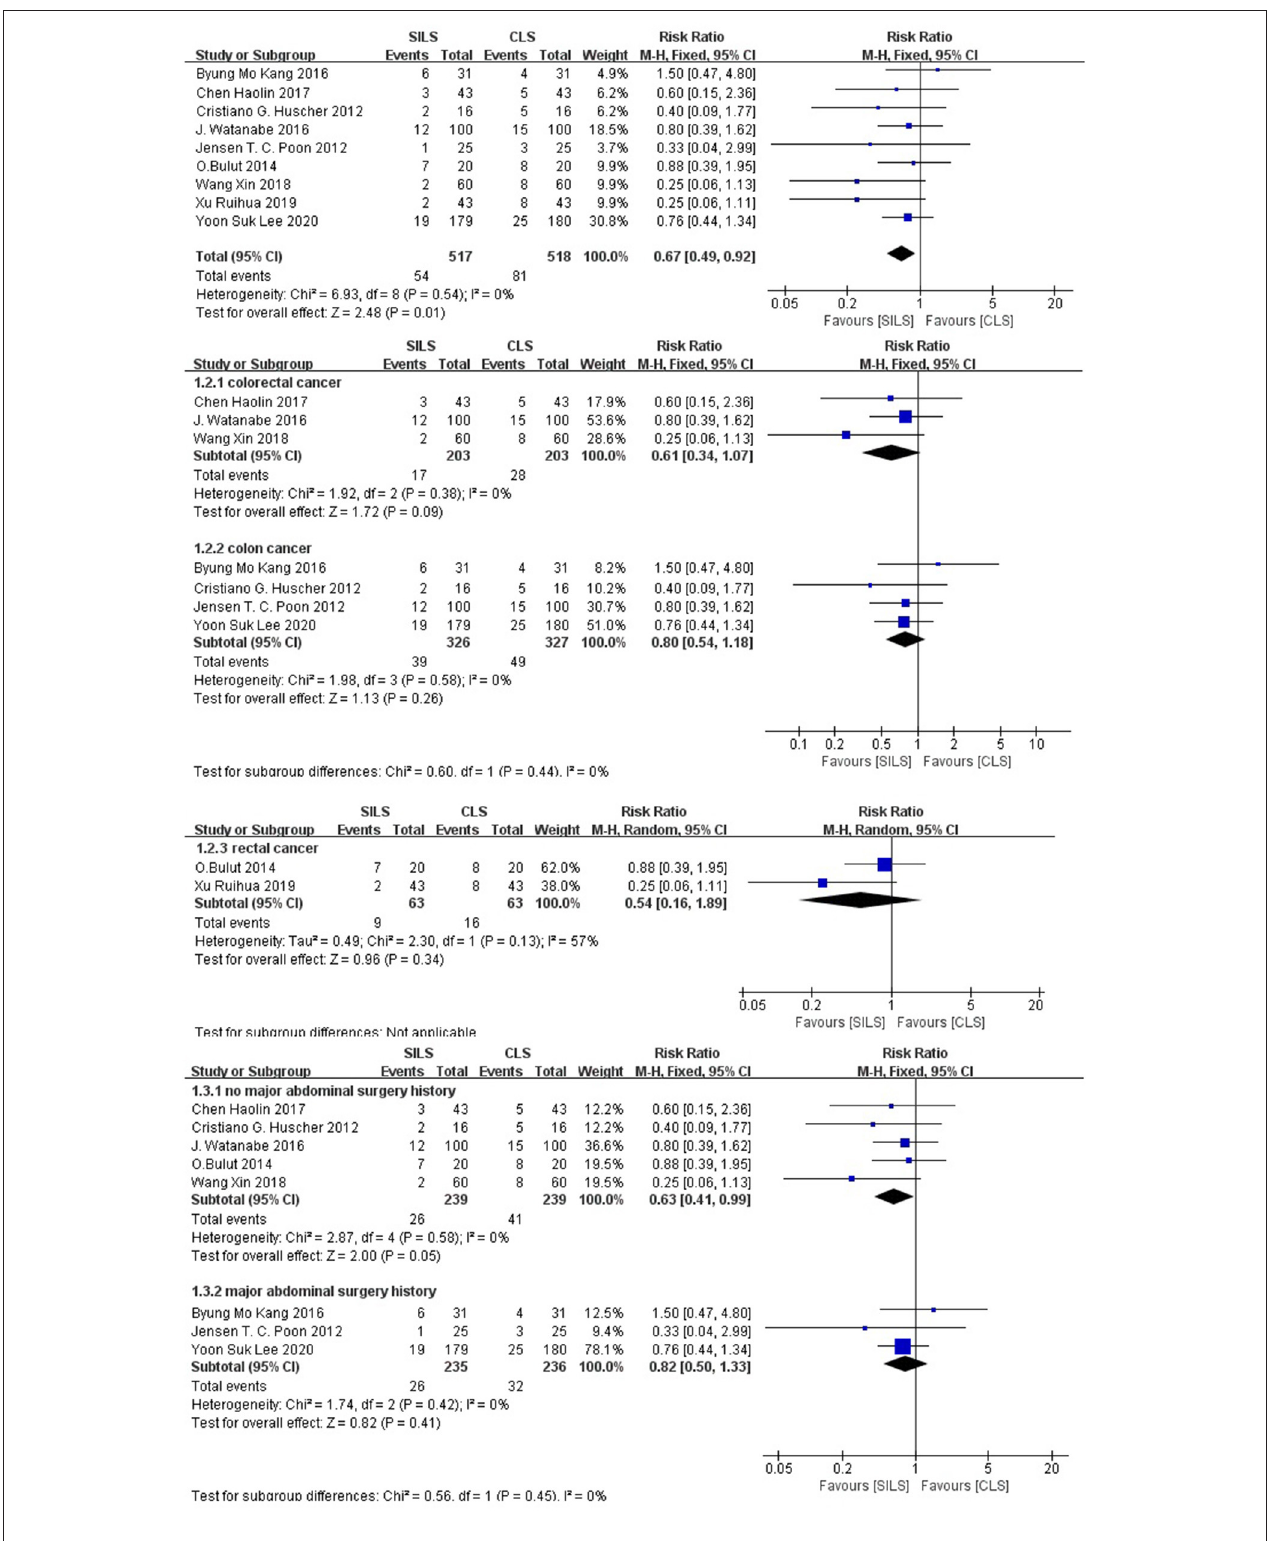
FIGURE 2 | Meta-analysis of postoperative complications. SILS, single-incision laparoscopic surgery; CLS, conventional laparoscopic surgery.